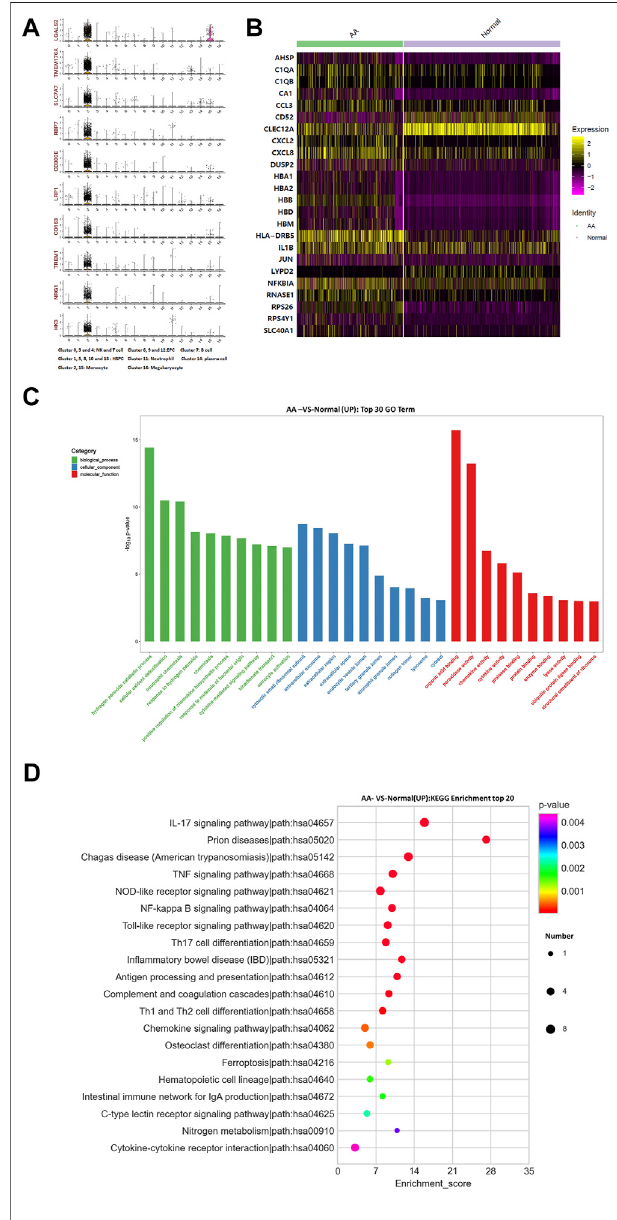
plot of the top 10 marker genes in monocytes. (B) Heatmap of differentially expressed genes in monocytes. (C) GO analysis of upregulated genes in monocytes. (D) KEGG pathway of upregulated genes in